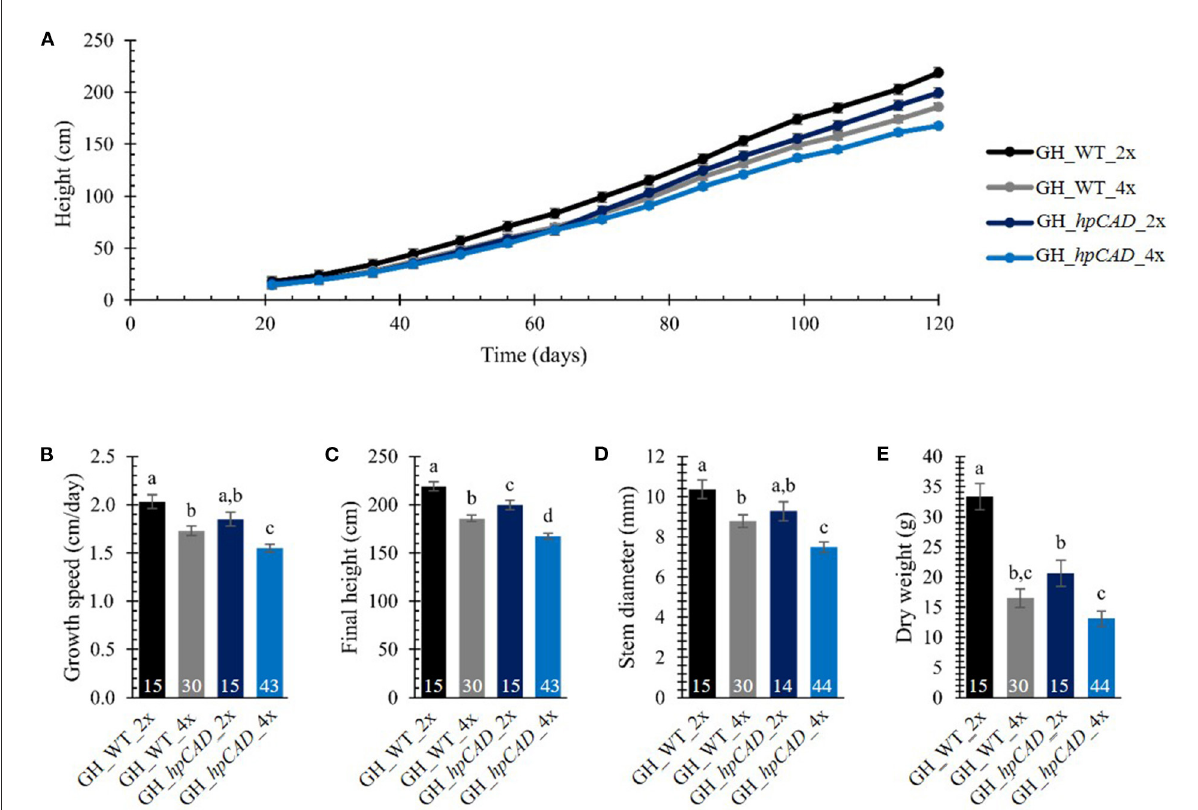
FIGURE2 Biomass yield of greenhouse-grown di- and tetraploid poplar trees. (A) Height over time. The height of the main stem was measured on a weekly basis over a period of 120 days. (B) Growth speed. (C) Final height of the poplars measured at day 120. (D) Stem diameter measured at harvest time 50cm above soil. (E) Total dry weight of the debarked tree measured at harvest time. The number of biological replicates is indicated in the bars. Data shown are adjusted mean ± standard error of the mean (SEM). Different letters represent significant differences at the 0.05 significance level. The significance differences for (A) are provided in Supplementary Table 1. For a detailed description of the models fitted to the data and the statistical tests used, see Supplementary Materials and Methods